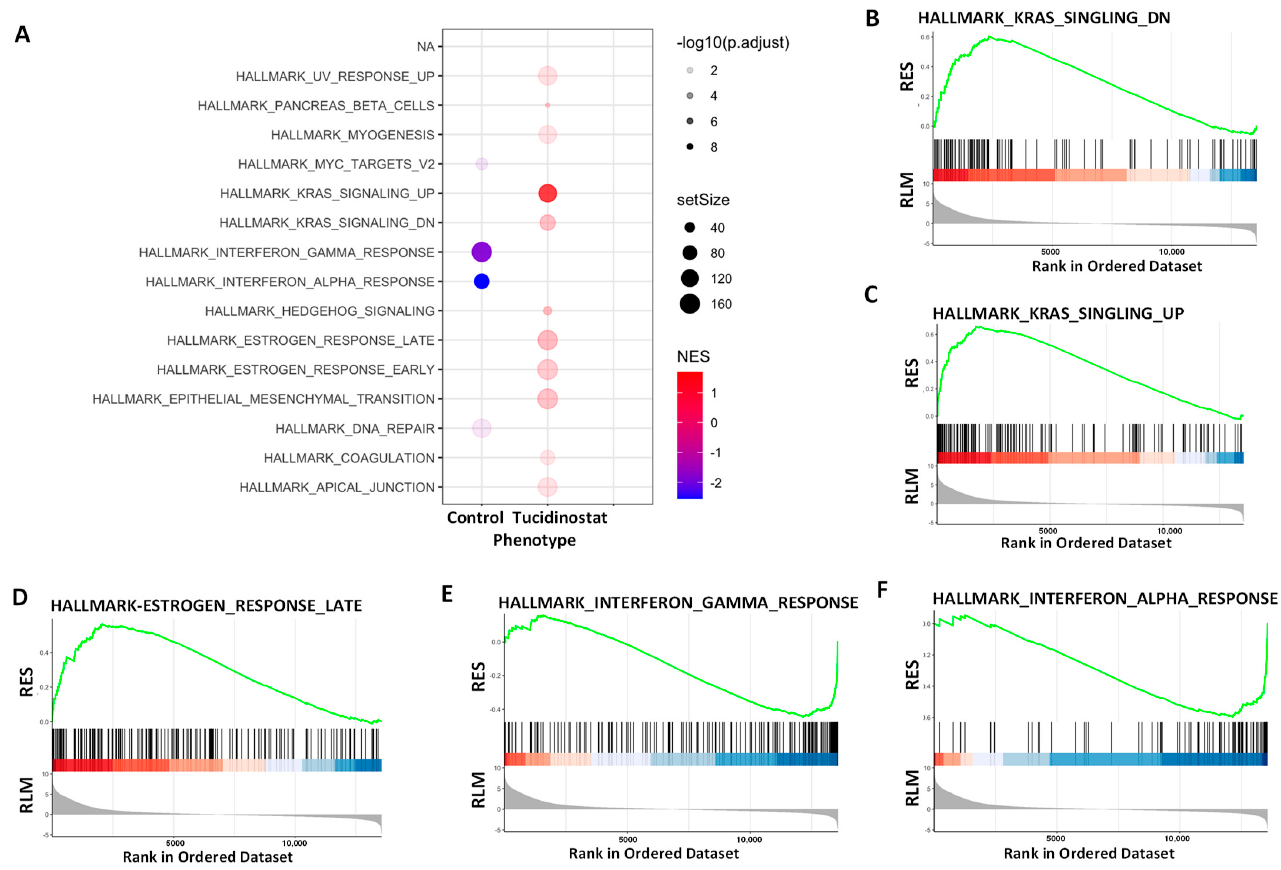
Figure 7. Hallmark analysis demonstrated the alteration of multiple pathways in SK-UT-1 cells in response to Tucidinostat (TD) treatment (Significantly enriched gene sets (HDAC inhibitor vs. control) from GSEA using Hallmark biological processes in MSigDB . ( A ) Functional pathways analysis identified significantly altered pathways in SK-UT-1 cells treated with Tucidinostat. Significantly enriched gene sets (Tucidinostat vs. control) from GSEA using Hallmark biological processes in MSigDB. Gene count and significance levels are shown by the size and color of each circle, respectively. Pathways analysis revealed that several gene sets were altered and associated with KRAS signaling ( B , C ), estrogen-response ( D ), interferon-response ( E , F ). RES: Running Enrichment Score; RLM: Ranked list metric.